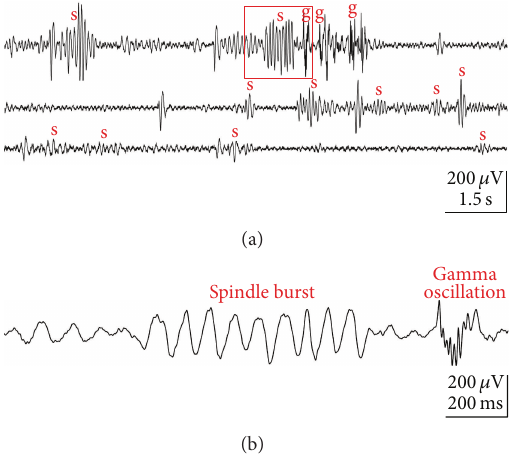
Figure 1: Spontaneous network activity recorded with an extracel- lular electrode array in primary somatosensory cortex of a P3 rat under light urethane anesthesia. (a) Continuous field potential (FP) recording showing several spindle bursts (s) and gamma oscillations (g). (b) Example of spindle burst and gamma oscillation marked in (a) by red box and displayed at expanded timescale. Reproduced with permission from